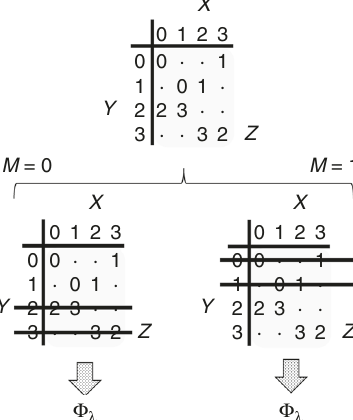
Fig. 1 A One-Round LOPC for Obtaining Secret Correlations from b (1, λ ) . Bob